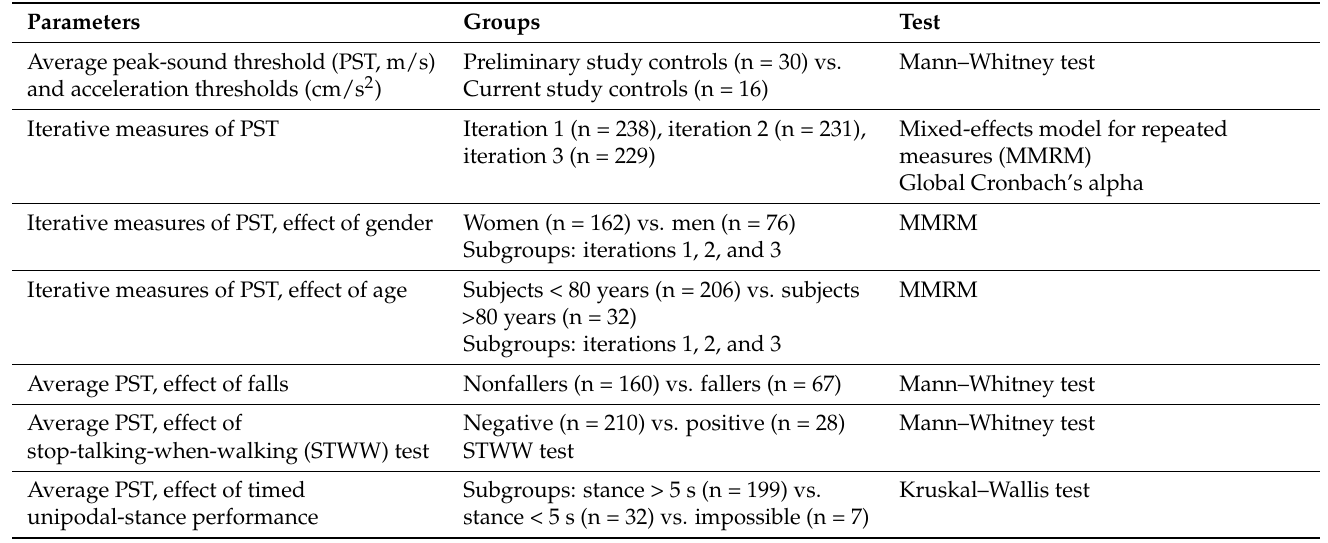
Table 2. Statistical tests performed in this study. BPPV: benign paroxysmal positional vertigo, UL: unilateral loss, PPPD: persistent postural-perceptual dizziness, BVP: bilateral vestibulopathy, VM: vestibular migraine, vs.: